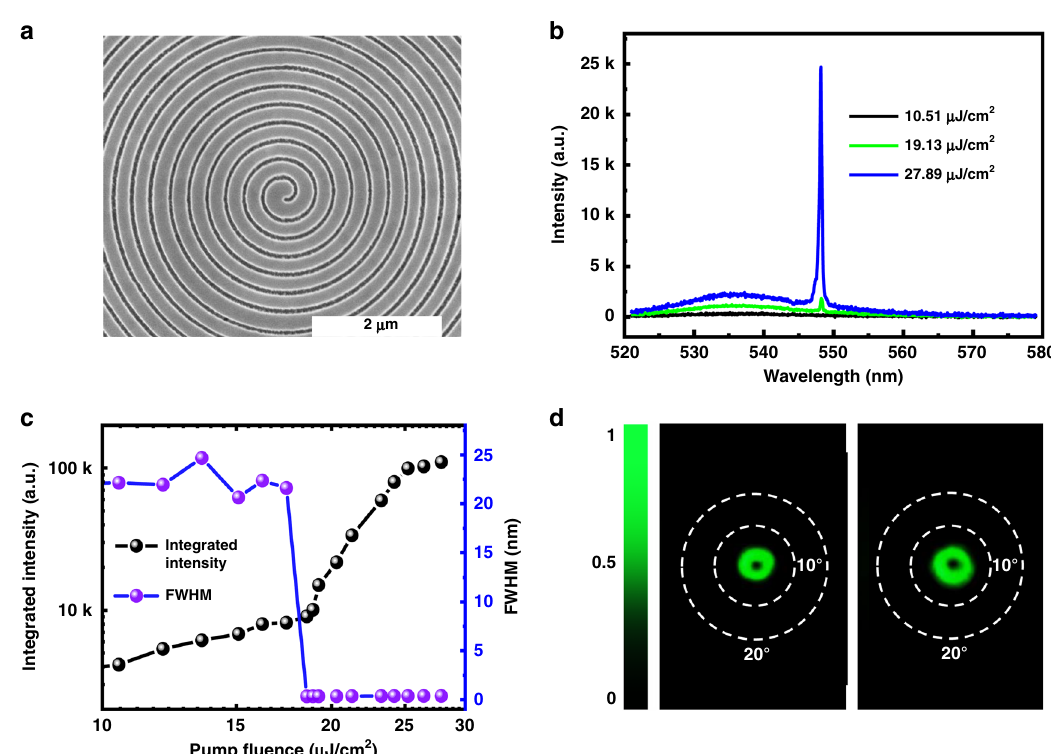
Fig. 3 The laser characteristics of Archimedean spiral gratings. a The top-view SEM image of the MAPbBr 3 perovskite Archimedean spiral grating. b The emission spectra of spiral grating at different pumping powers. c The dependence of output intensity (solid line) and FWHM (open squares) on the pump fl uence. d The corresponding far fi eld laser pro fi les in the forward direction and backward direction. The white dashed lines represent the angles of 10° and 20°,